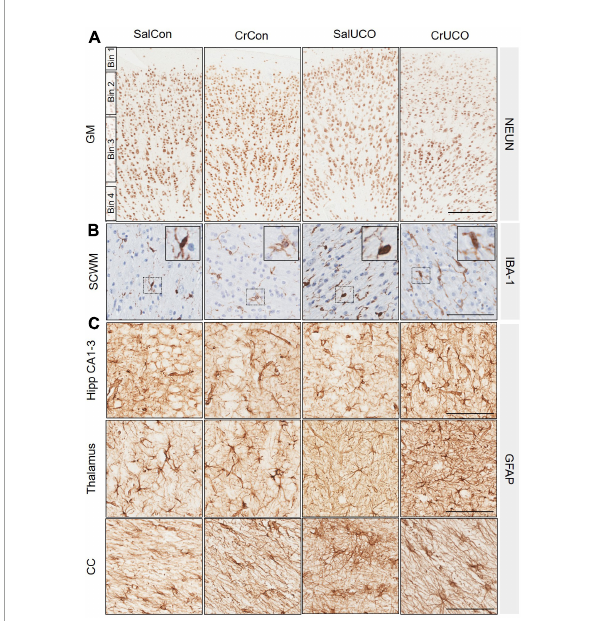
FIGURE3 (A) Representative images of NeuN-positive cells indicating mature neurons in the cortical grey matter (GM). GM counts were conducted in four bins roughly equivalent to cortical layer I (Bin 1), layer II and III (Bin 2), layer IV and V (Bin 3), and layer VI (Bin 4). No significant differences of bins were found between groups, therefore data were combined and presented as a total average for GM. (B) Representative images of IBA-1-positive cells indicating microglia in the subcortical white matter (SCWM). Insert demonstrates ramified microglia. (C) Representative images of glial fibrillary acidic protein (GFAP)-positive cells and processes indicating astrocytes in the dorsal hippocampal (Hipp) CA1-3, thalamus and corpus callosum (CC). Scale bar represents 100 µ m.